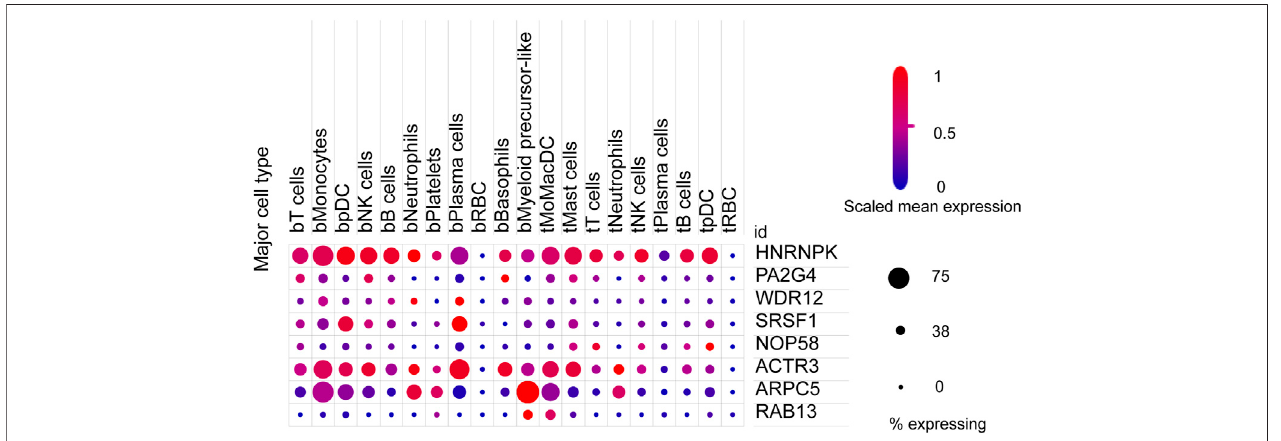
FIGURE7| Expressionofeighthubgenecandidates invariousclustersofhumanimmunecellsfromnon-smallcelllungtumor(t)and peripheralblood(b).t,tumor; b,blood;DCs,dendriticcells;pDCs,plasmacytoidDCs;RBC,redbloodcell.Thesizeofdotsrepresentsthepercentageofexpression;redandbluerepresentthelevelof scaled mean